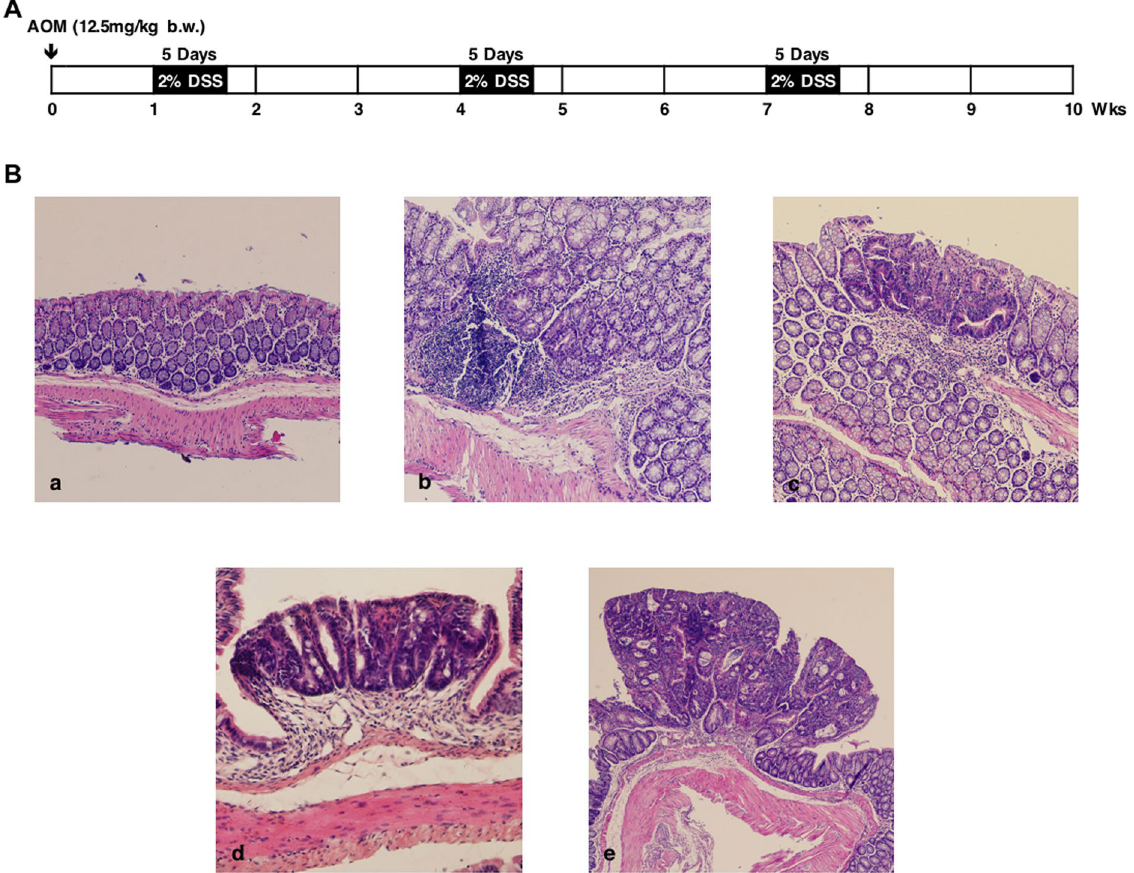
Figure 1. Establishment and histopathological evaluation of AOM/DSS mouse model. ( A ) Schedule of model establishment. ( B ) Histopathology of colonic dysplasia in different phases of model establishment: a) normal colorectal mucosa, x10; b) colorectal mucosa, 4 weeks of AOM/DSS treatment, x10; c) ACF, 7 weeks of AOM/ DSS treatment, x10; d) adenoma, 7 weeks of AOM/DSS treatment, x20; e) adenocarcinoma, 10 weeks of AOM/ DSS treatment,